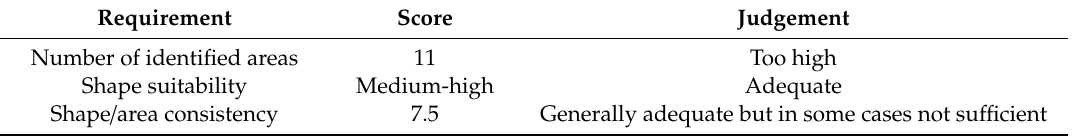
Table 3. Assessment of the criterion: subdivision by historical aspects.